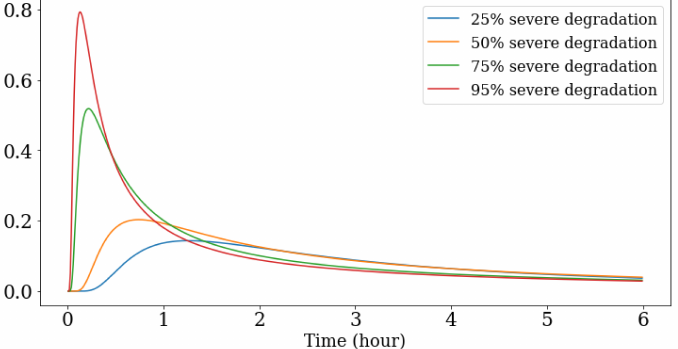
Figure 7. PDF of remaining useful life at different percentage of bearing’s life.